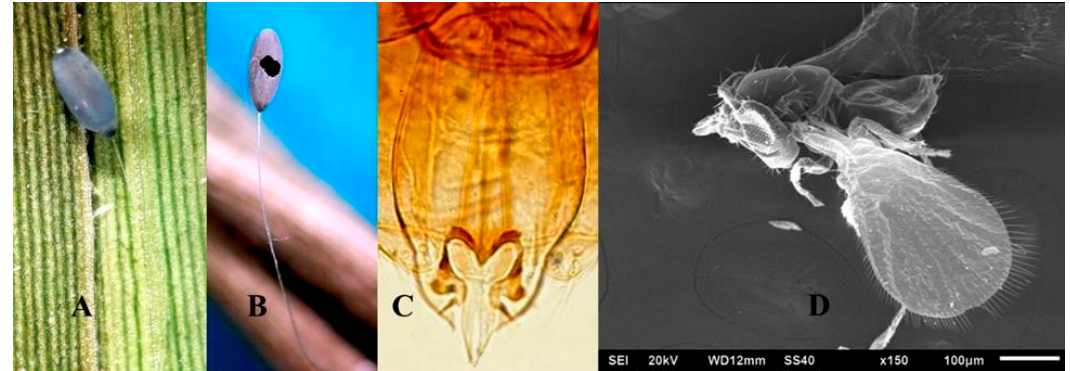
Figure 4. ( A ) Egg parasitized by Trichogramma atopovirilia , ( B ) Chorion of chrysopid egg parasitized by Tr . atopovirilia , ( C ) Male genitalia (photo by Fabián García), ( D ) Female of Tr .